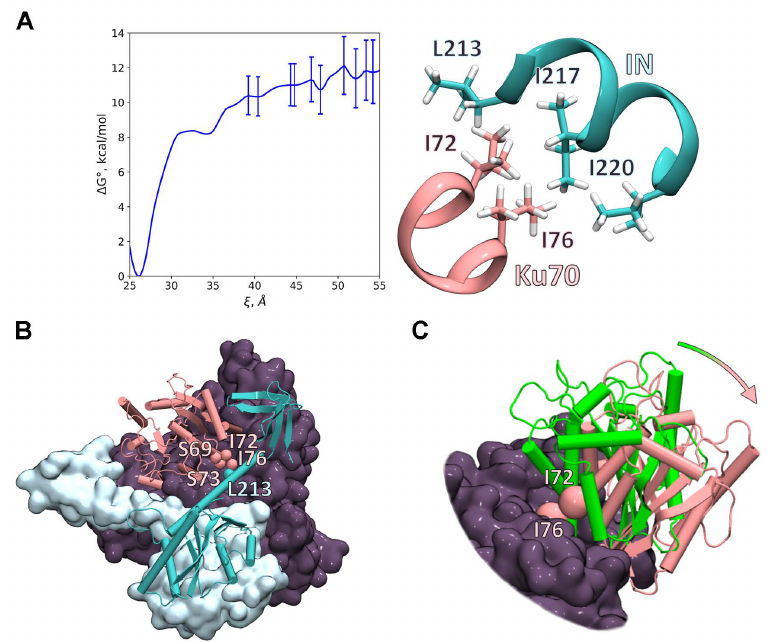
Figure 3. Three-dimensional model of the Ku70/IN complex. ( A ) Gibbs energy profile of the N- terminal domain of Ku70 and IN binding. The error bars are calculated using umbrella integration approach. The inset demonstrates the hydrophobic binding motif of the so-called “leucine zipper”. Ku70 and IN carbon atoms are colored pink and cyan, respectively, and hydrogen atoms are white. ( B ) Calculated structure of the Ku70/Ku80 heterodimer and IN dimer complex. IN dimer is shown in light blue: the monomer that interacts with the N-terminal domain (up to 250th residue) of Ku70 is shown in cartoon representation. The dark isosurface is the Ku70/Ku80 heterodimer, except the N-terminal domain of the Ku70, which is shown in pink cartoon representation. ( C ) Alignment of the crystal structure of Ku70/Ku80 heterodimer (PDB ID: 1JEQ [33]) and the calculated structure. The N-terminal domain of Ku70 from the PDB ID: 1JEQ is shown in green. The arrow shows the rotation direction of the N-terminal Ku70